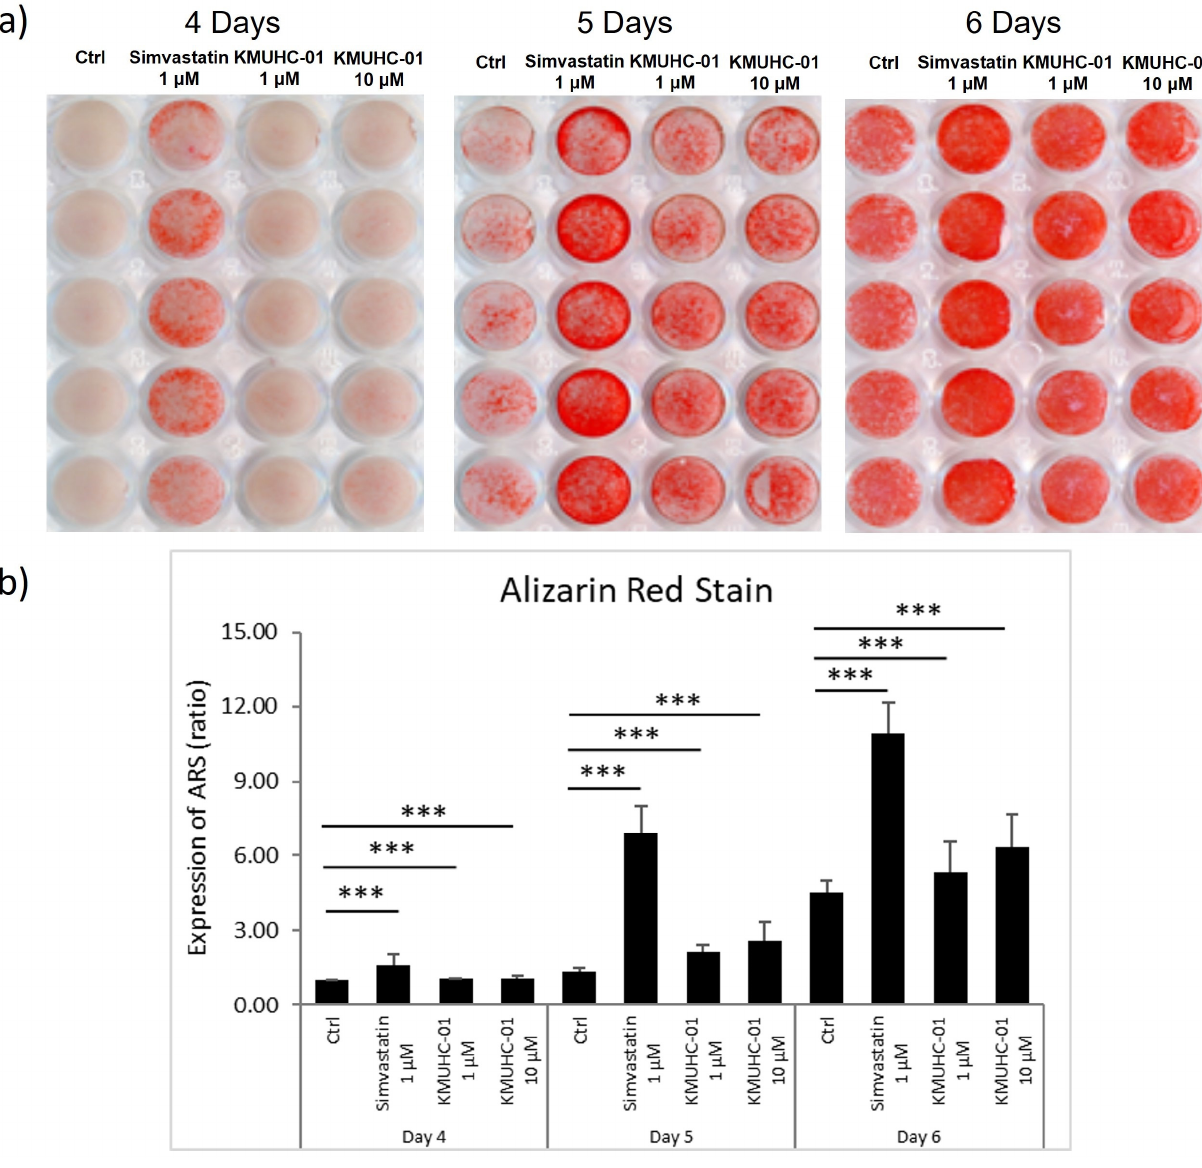
Figure 3. Mineralization of D1 cells treated with simvastatin and KMUHC-01. ( a )Alizarin Red S (ARS) staining; ( b ) the quantified amount of calcified material. (*** p < 0.005, comparison with control group)